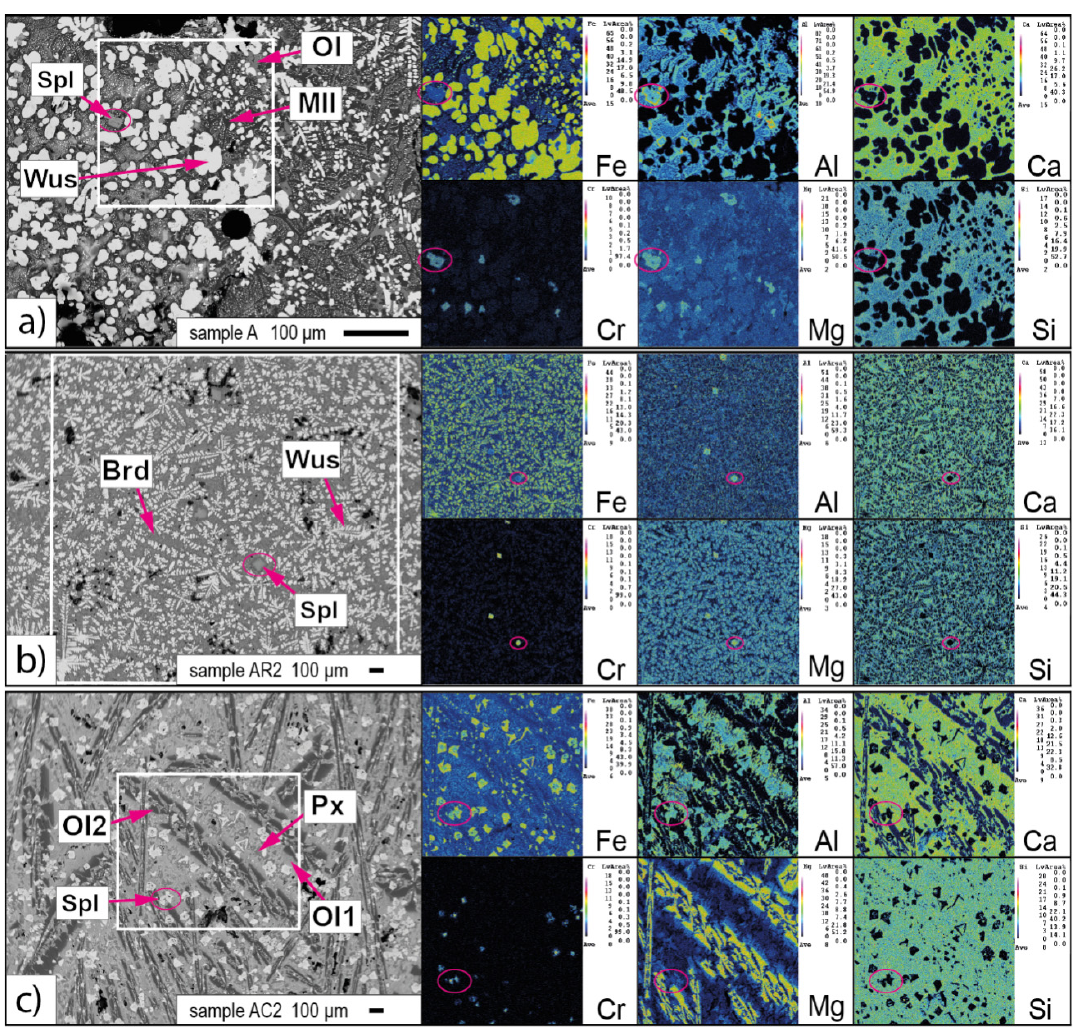
Figure 3. Back scattered electron (BSE) images and element mappings (Fe, Al, Ca, Cr, Mg, Si) of samples derived from the laboratory experiments: ( a ) sample A, ( b ) remelted sample AR2 (moderate cooling) and ( c ) conditioned sample AC2 (moderate cooling). Circles mark the element distribution in the spinel phase as an example. Abbreviations according to Whitney and Evans (2010) [28]: wuestite solid solution (Wus), spinel solid solution (Spl), olivine group phase (Ol), melilite group phase (Mll), bredigite (Brd), Ca-rich olivine (Ol1), Mg-rich olivine (Ol2), and pyroxene (Px). Phases identified via x-ray diffraction (XRD) and, if possible, via quantitative electron microprobe (EMP) analyses.